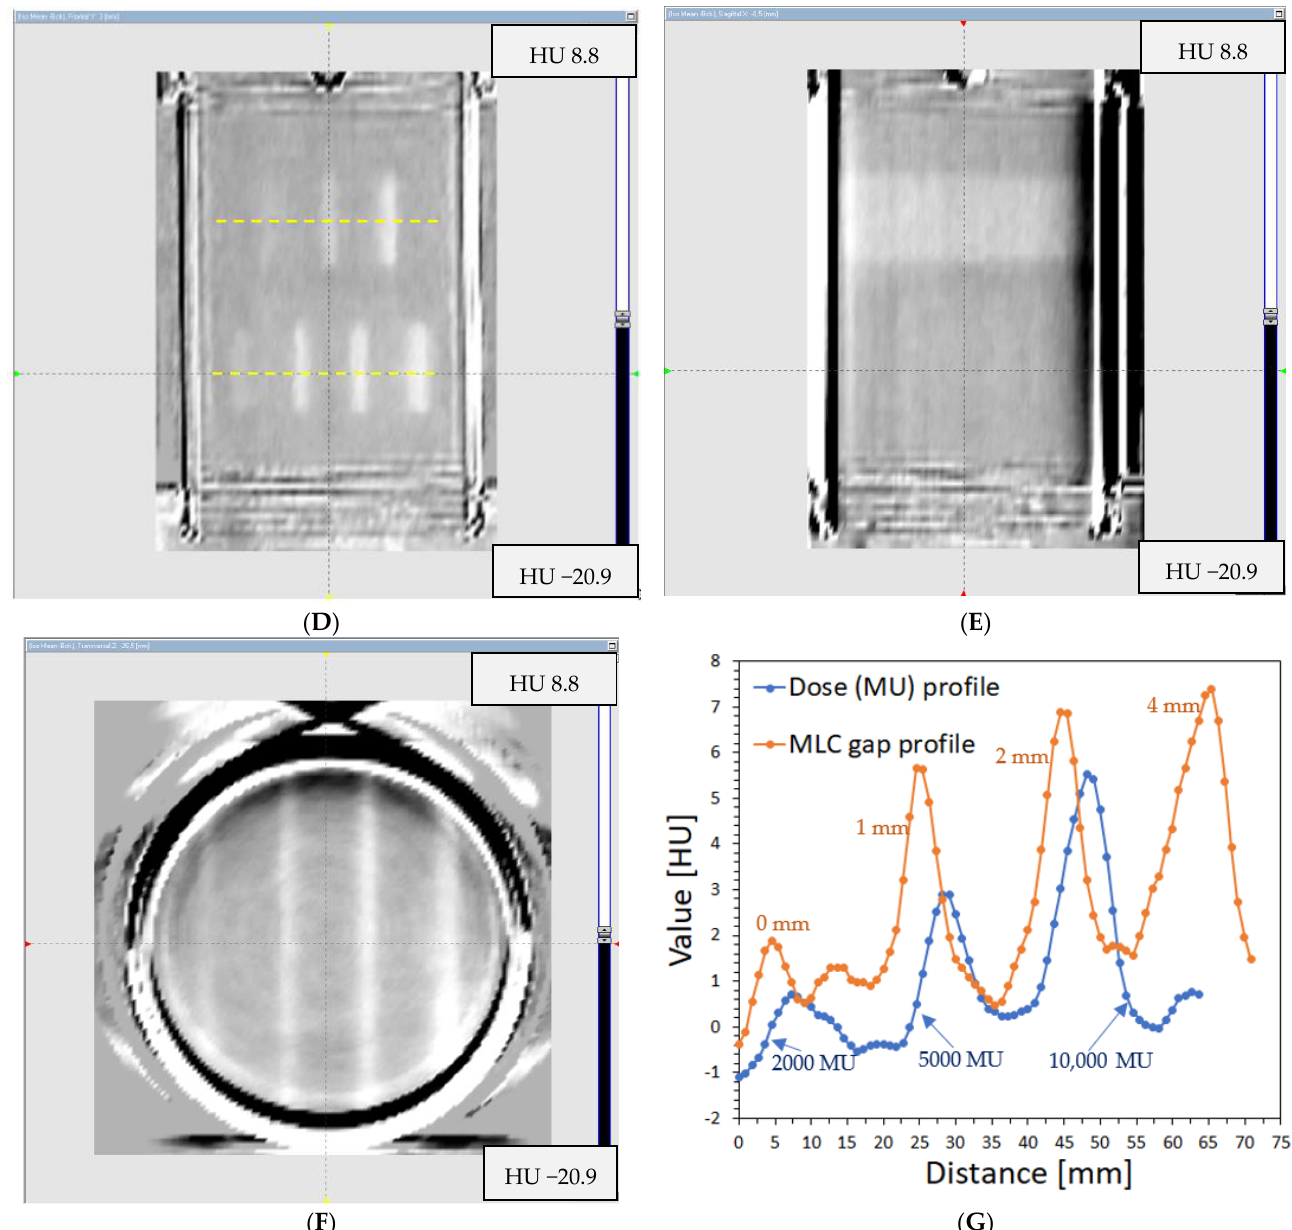
Figure 3. Selection of the radiation field parameters: multi-leaf collimator (MLC) gap and dose (MU) for the determination of the isocenter. The study was performed for PABIG nx in a PH-6-DD2 container (GeVero Co.). In ( A – C ), there are photographs of the dosimeter after irradiation; ( A ) is a bottom view in a horizontal position, ( B ) is a front view of the container in a vertical position and ( C ) is a side view of the container in a horizontal position. The irradiated regions ( B ) correspond to different gaps of MLC (closer to the bottom of the container in ( B )): 0, 1, 2 and 4 mm (for 10,000 MU), from left to right, and they correspond to 2000, 5000 and 10,000 MU, from left to right (closer to the top of the container in ( B )). ( D – F ) are CT images (iCBCT, TrueBeam, Pelvis): for frontal Y: 3 mm; sagittal X: −0 .5 mm; and transversal Z: 23.4 mm, respectively. In ( G ), profiles across the irradiated regions, corresponding to the irradiated regions for different gaps of MLC and MU, are presented. The yellow dash lines in ( D ) indicate the positions of the profiles in ( G ). The profiles were smoothed by applying a mean filter (Kernel mode: 2D, Kernel unit: pixels and Kernel size 5 and 3 for Dose (MU) profile and MLC gap profile, respectively).